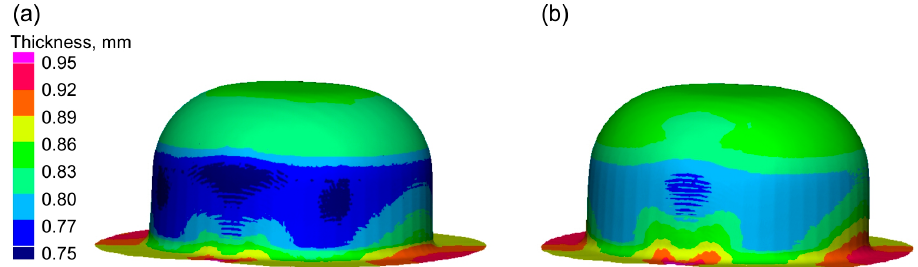
Figure 13. Thickness distribution in the drawn part wall: ( a ) dry friction; ( b ) with lubricant.